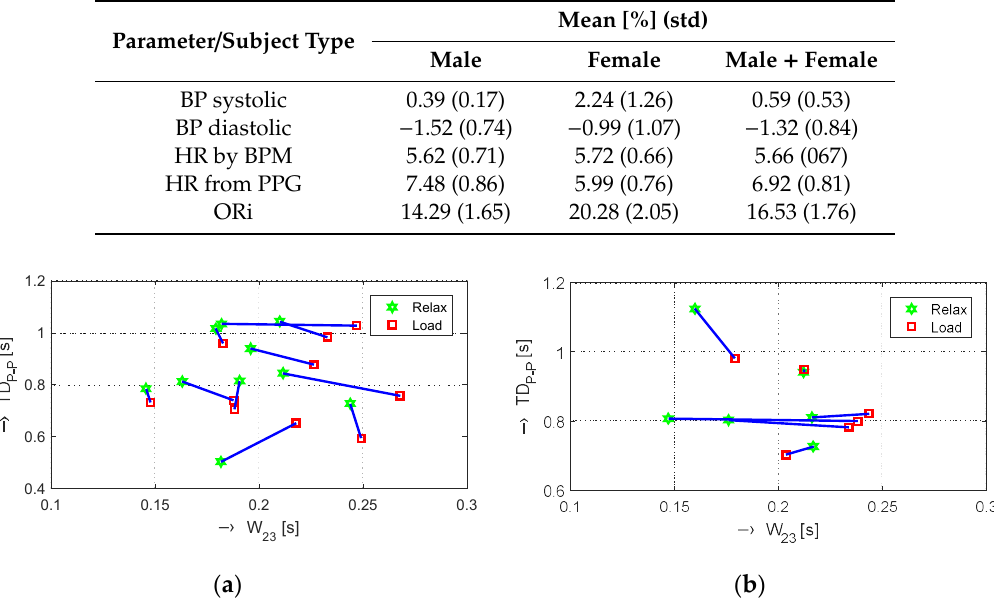
Figure 8. Visualization of mutual positions of TD P-P and W 23 parameters—compare with the examples of graphs in Figures 5, 6 and 7b,c determined from histograms in Relax and Load phases for ( a ) male and ( b ) female persons. Table 2. Mean (std in parentheses) values of relative differences in [%] of blood pressure (BP), heart rate (HR), and Oliva–Roztocil index (ORi) parameters between Relax and Load phases obtained from auxiliary and preliminary experiments. BPM, BP monitor.